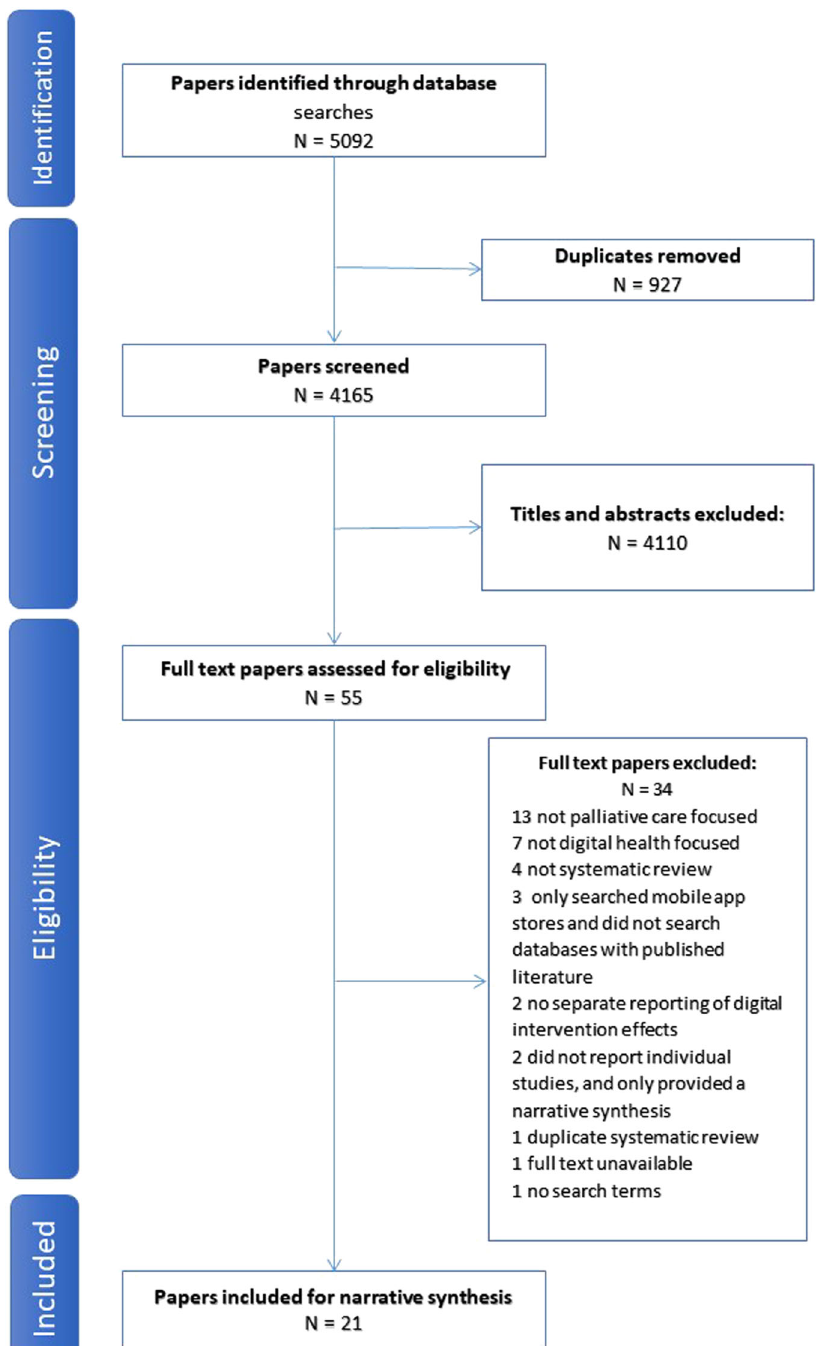
Fig. 1 Prisma fl ow diagram. Overview of the search